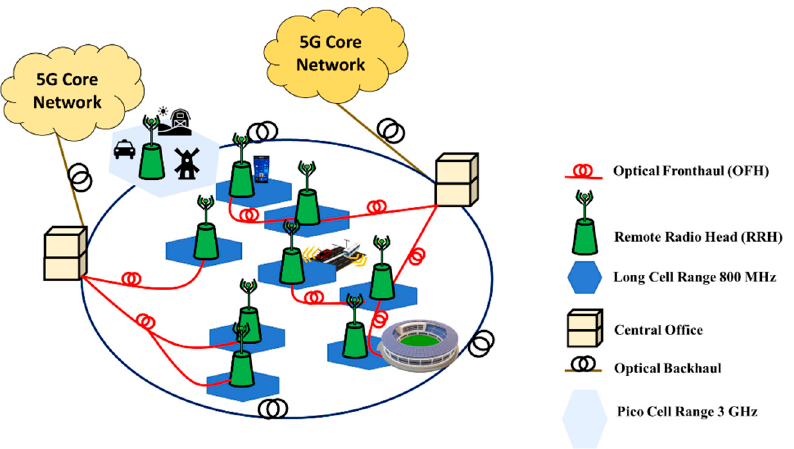
Figure 1. Block diagram of Centralized/Cloud Radio Access Network (C-RAN)-based 5G applica- tion system comprising backhaul, fronthaul and application scenarios such as stadiums, railways, transport and factories.